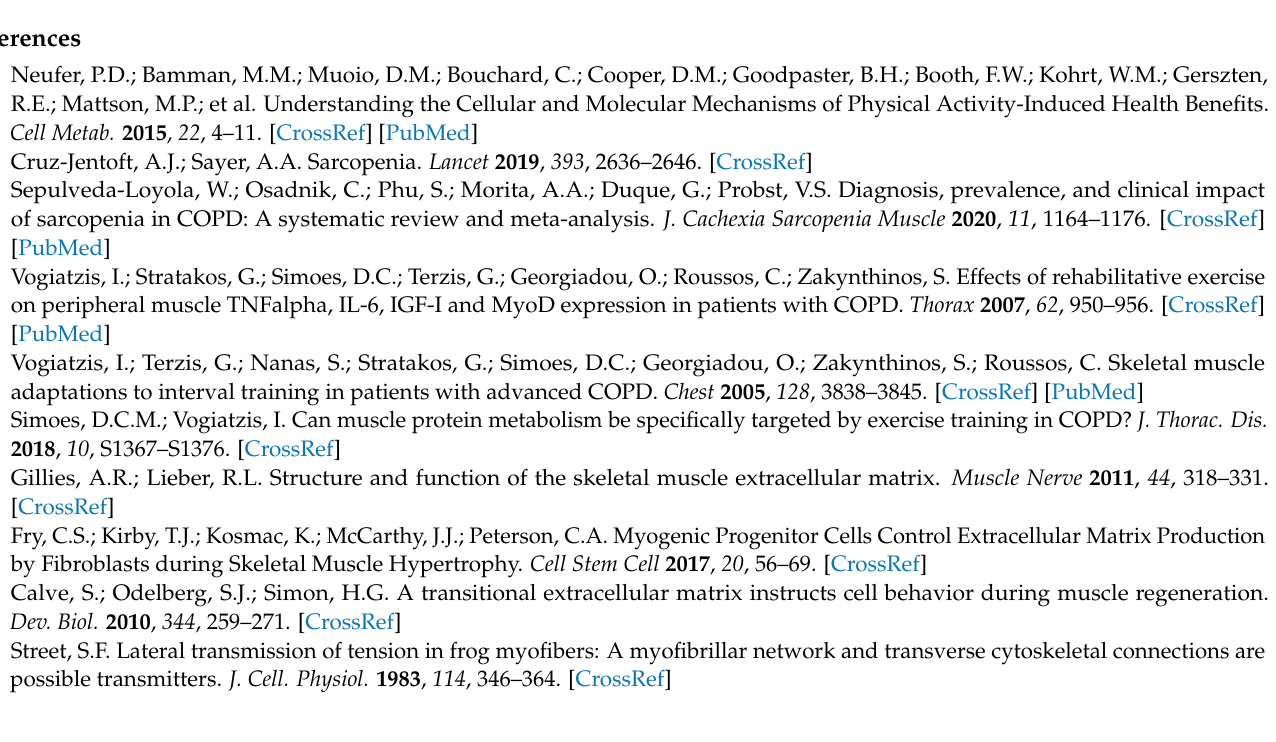
Supplementary Materials: The systematic review search strategy for PUBMED (Table S1), and results on the changes in ECM-related molecules after exercise training intervention (Table S2)